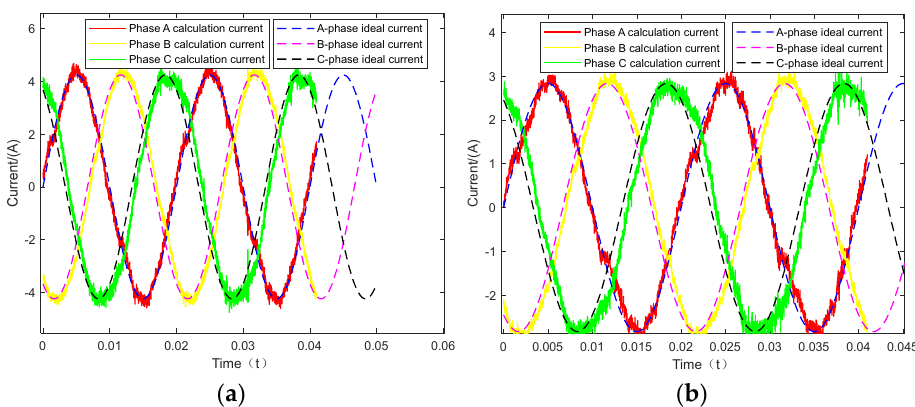
Figure 17. Di ff erent current reduction waveforms. ( a ) Restore waveform when current is 4 A; ( b ) restore waveform when current is 5 A.